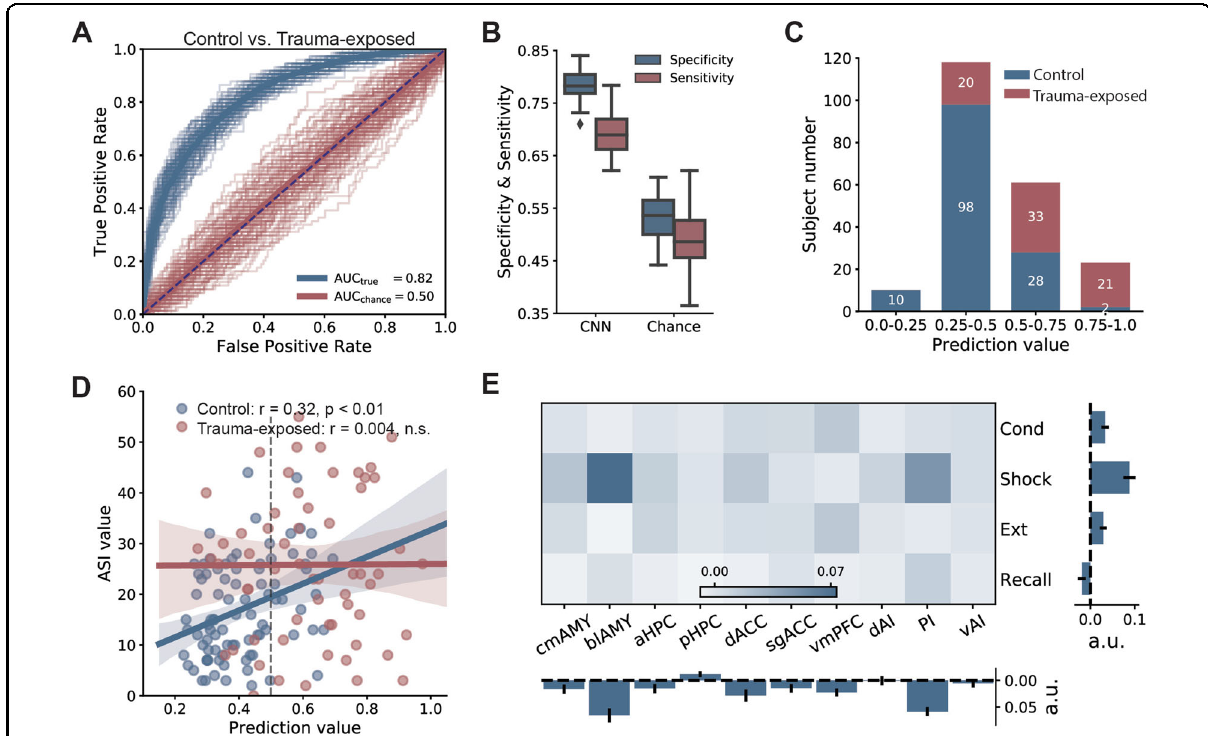
Fig. 3 Performance for discriminating trauma-exposed brains from controls. A ROC curves derived from 5-fold cross-validation. B Box plots of speci fi city and sensitivity. C Empirical distribution of prediction scores. D The prediction score positively correlated with ASI for the control group (Spearman r = 0.32, p = 0.0024), but at the chance level for trauma-exposed group (Spearman r = 0.004, p = 0.97). E The relative importance of 40 brain activation features assessed by their